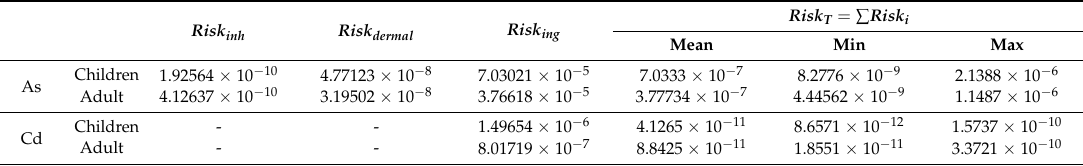
Table 4. The index of carcinogenic health